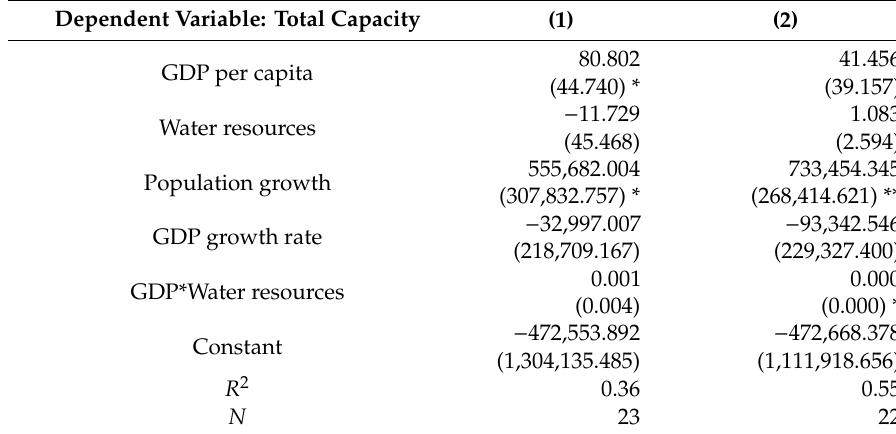
Table 3. Estimates from Equation